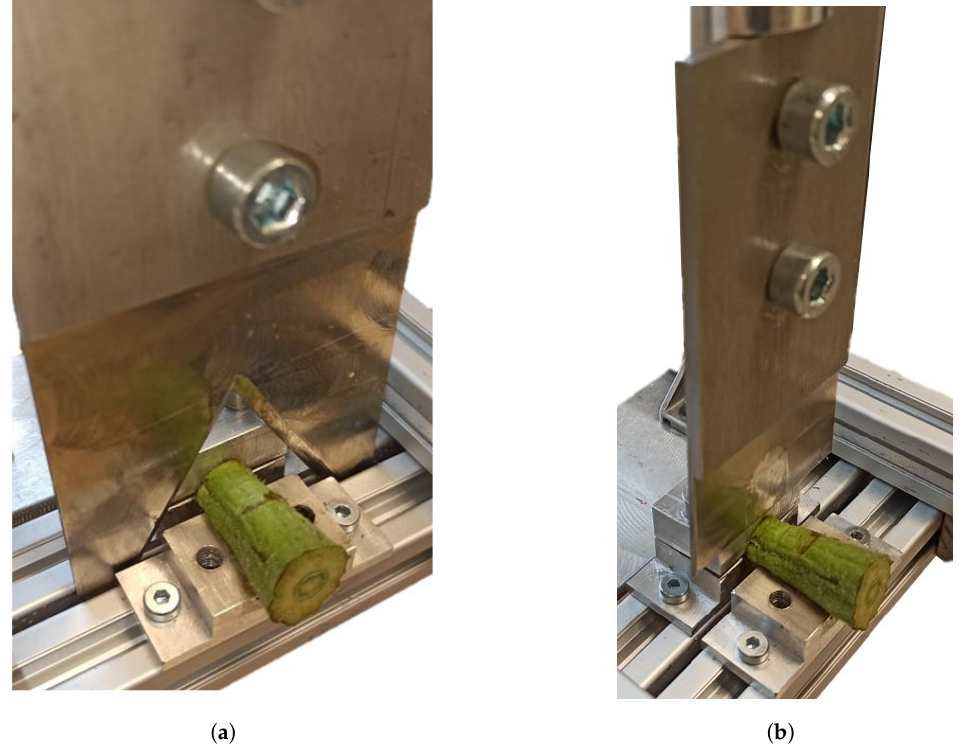
Figure 7. Both blades with a peduncle in a half-mounted clamp. ( a ) Notched blade; ( b ) straight